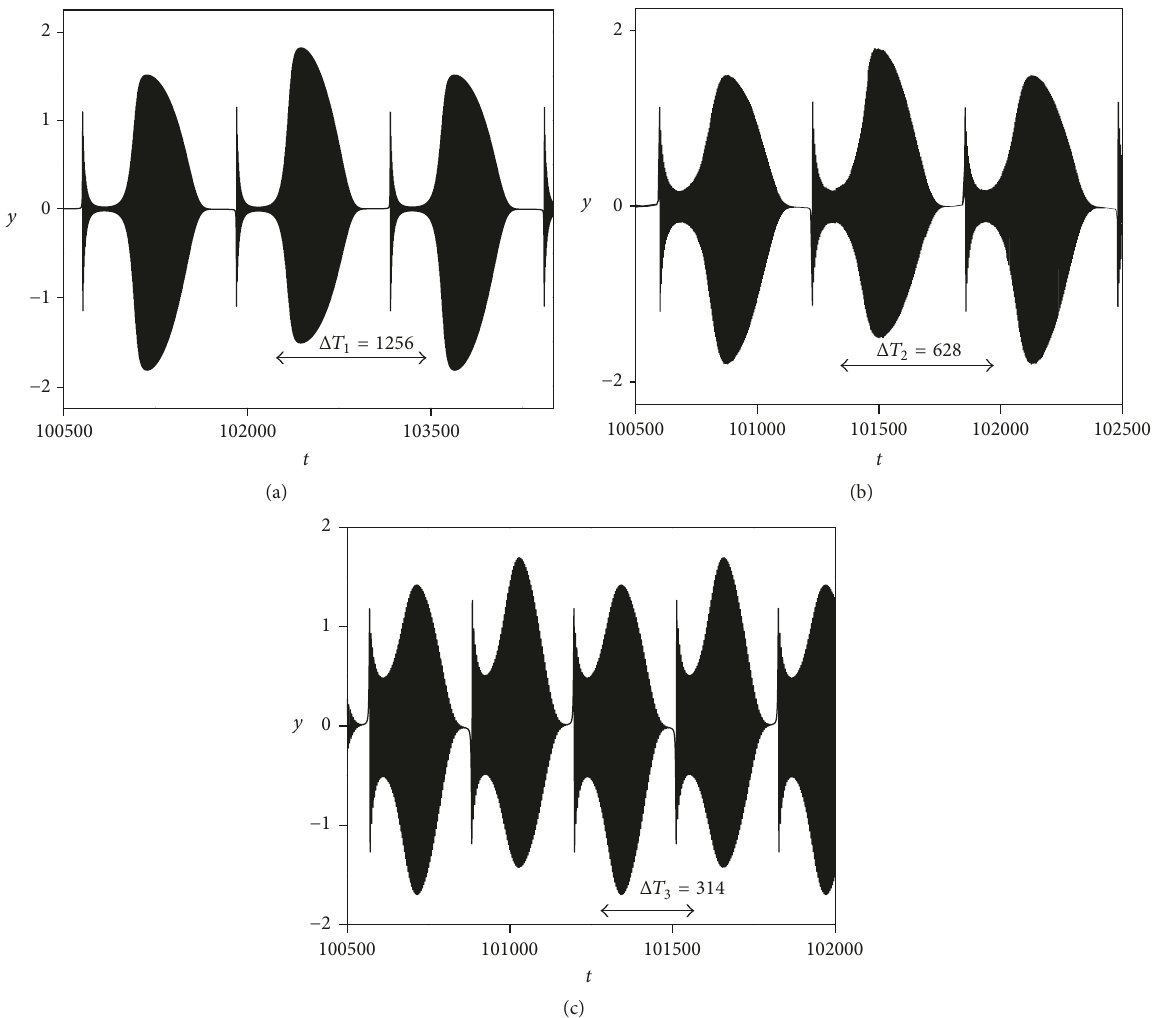
Figure 8: Numerical results of the time interval between two adjacent spikes of bursting oscillations corresponding to Figure 7 for the slow excitation frequency for 𝜔 1 = 0.0025 , 𝜔 2 = 0.005 , and 𝜔 3 = 0.01 , respectively. (a) Δ𝑇 1 ≈ 1256 ; (b) Δ𝑇 2 ≈ 628 ; and (c) Δ𝑇 3 ≈ 314